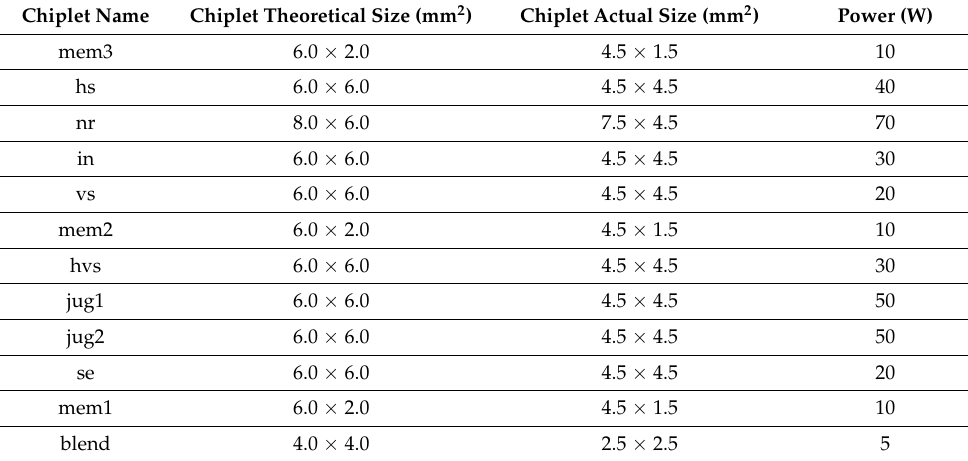
Table 2. Chiplet sizes and powers of the multi-window display system.